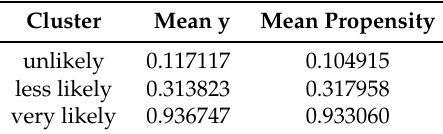
Figure 4. ( a ) Clustering of Shapley values with K = 4; ( b ) Propensity to buy: Precision/Recall curve (Area Under the ROC Curve = 0.91). Table 1. Mean by